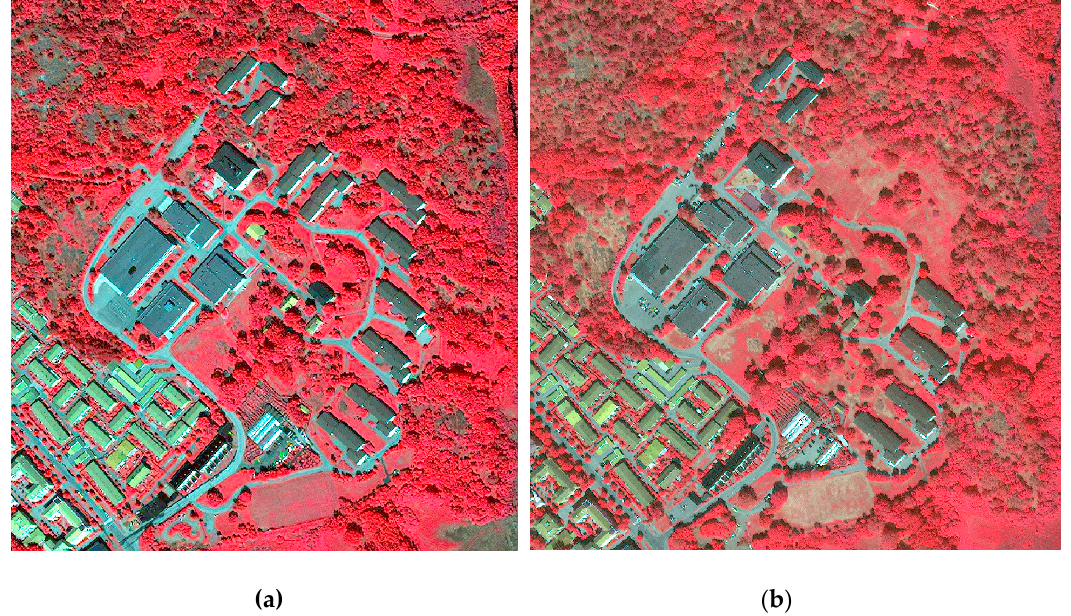
Figure 13. Example of regreening in Skarpnäck: ( a ) 2003 and ( b ) 2018